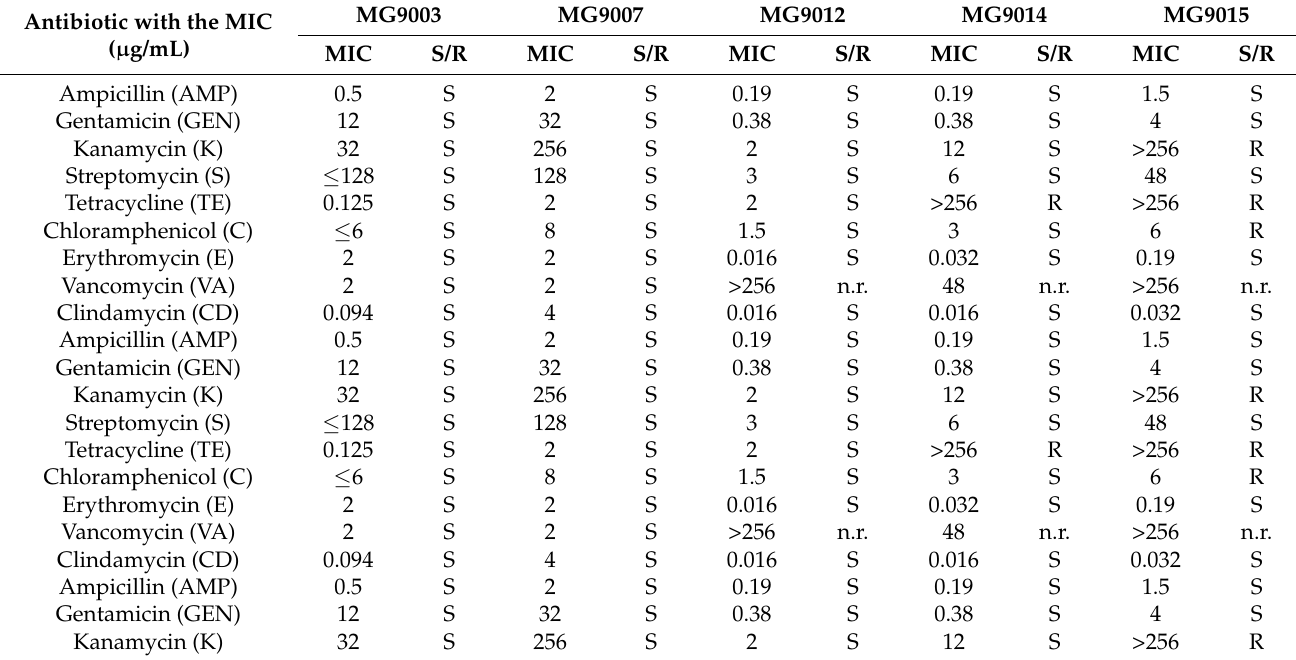
Table 4. Minimum inhibitory concentrations (MICs) of different antibiotics for the selected